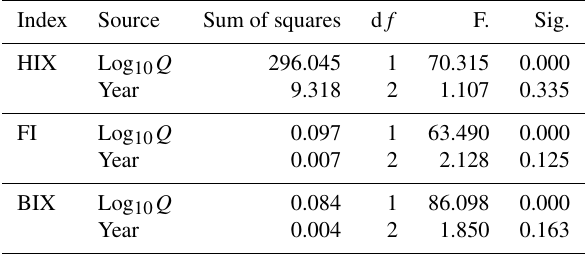
Table 5. Results of covariance analysis (ANCOVA) between dis- charge and the fluorescence indices for the study